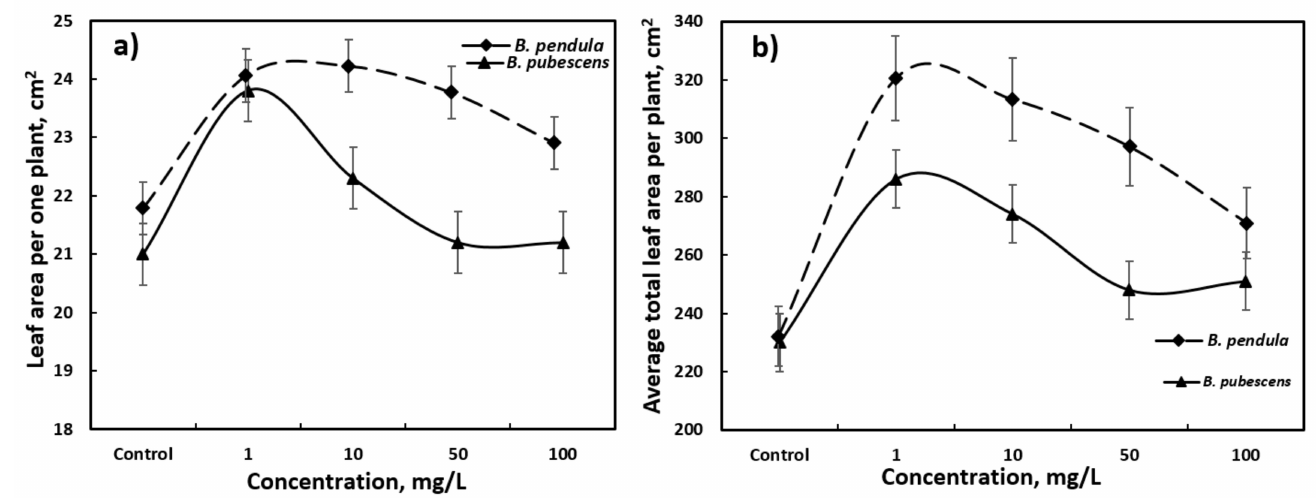
Figure 7. Leaf area ( a ) and total leaf surface ( b